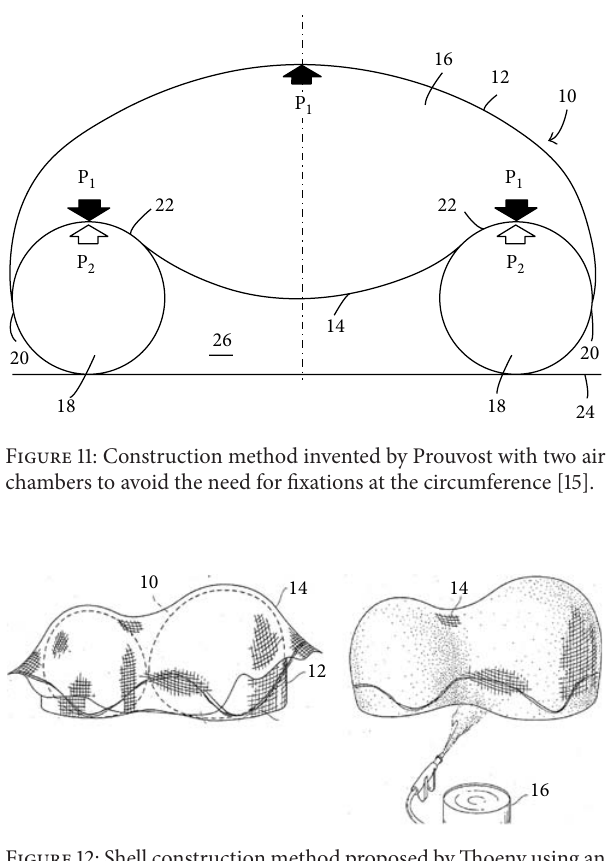
Figure 12: Shell construction method proposed by Thoeny using an additional fabric layer before applying shotcrete